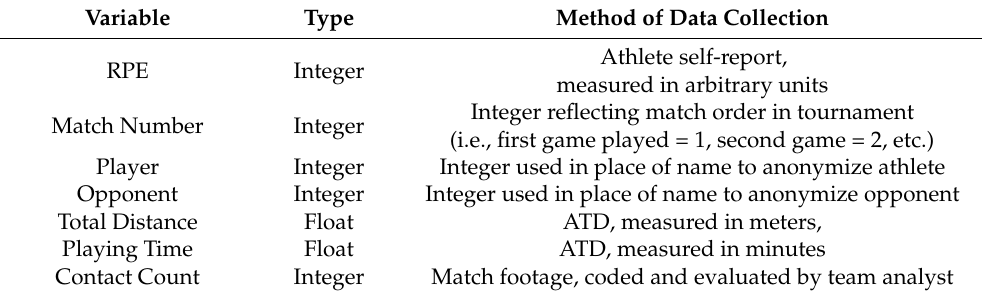
Table 1. Details on explanatory variable data used in